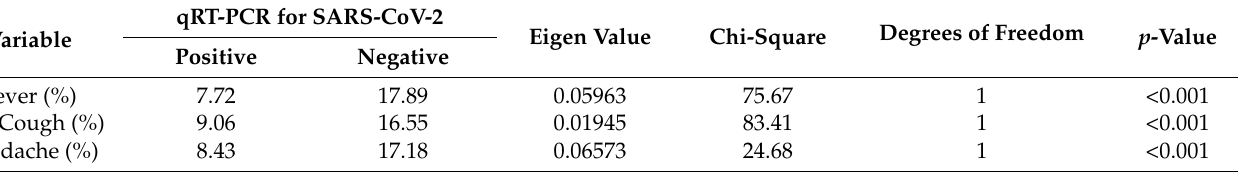
Table 4. Correspondence analysis for symptoms with significant p